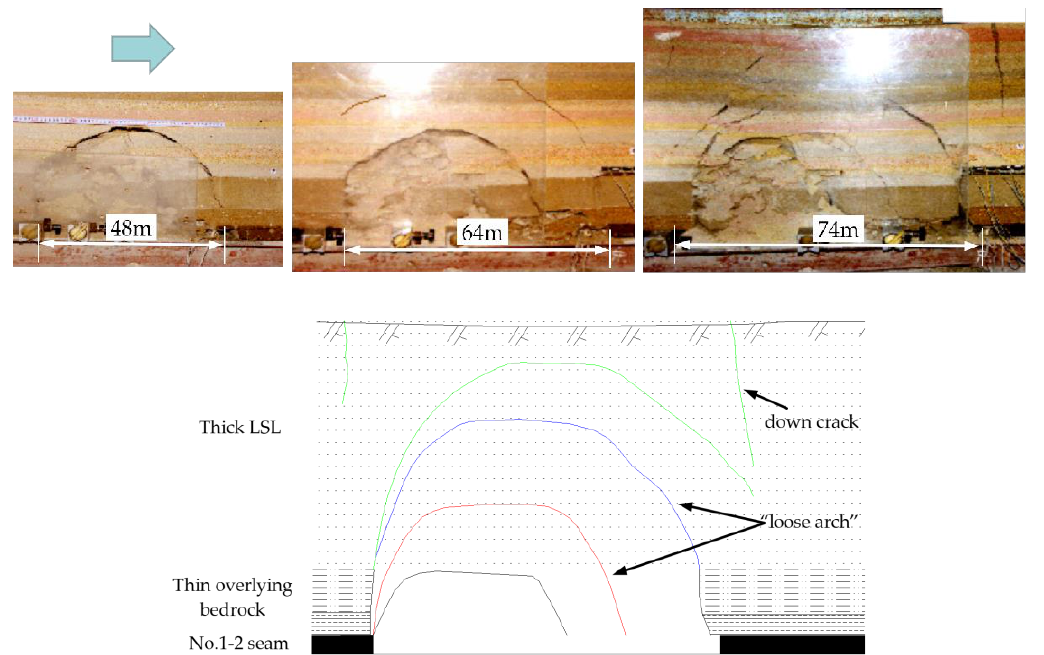
Figure 3. Sketch drawing of evolution of periodic cracks in mining.